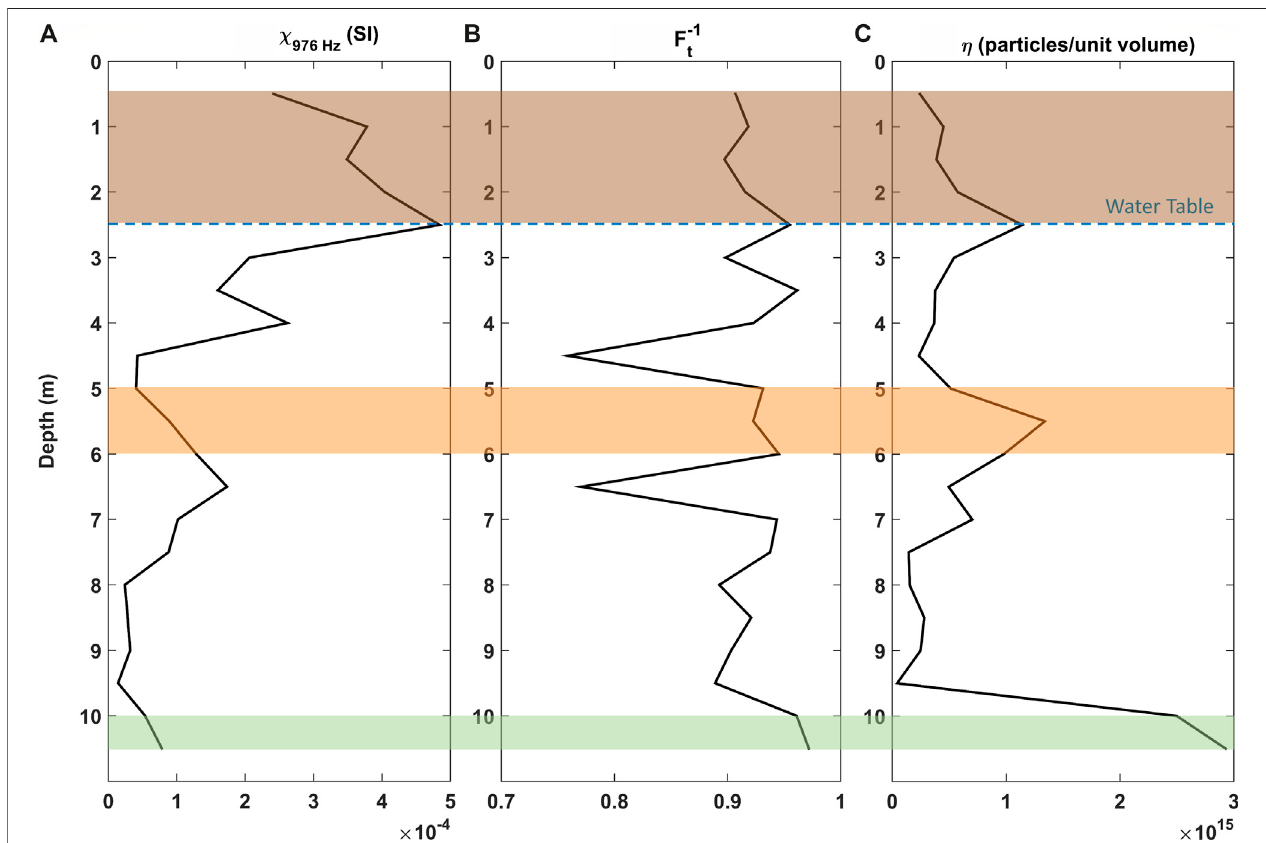
FIGURE 5 | Interpretation parameters: (A) Magnetic susceptibility, χ , (B) transition parameter, F − 1 t and (C) concentration of superparamagnetic particles, η . The gas pockets depths are highlighted in brown, orange and green. χ show a more magnetic soil at the vadone zone (depth < 2.5 m). F − 1 t indicates highest variations of magneticparticlesizesintheSP-SSDthresholdattheboundariesofthesecondgaspocketzone(4.5and6.5 m). η ishigherinthegaspocketsdepthsthanintherestof core samples.